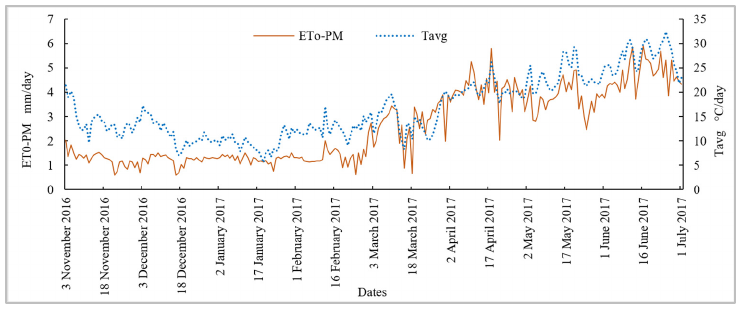
Figure 2. Variation of ET0 and average daily temperature (Tavg) during the 2016/2017 agricultural season.